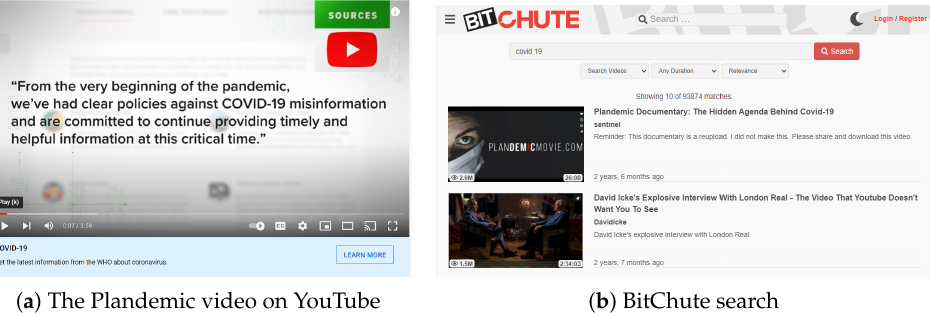
Figure 1. ( a ) Screenshot of the Plandemic misinformation video entitled ‘VERIFY: “The Plandemic” documentary being shared on social media is full of misinformation’. The video still exists on the platform with a verification tag. Accessed on June 2022 and ( b ) Search on BitChute with the keyword ‘COVID 19’ accessed on June